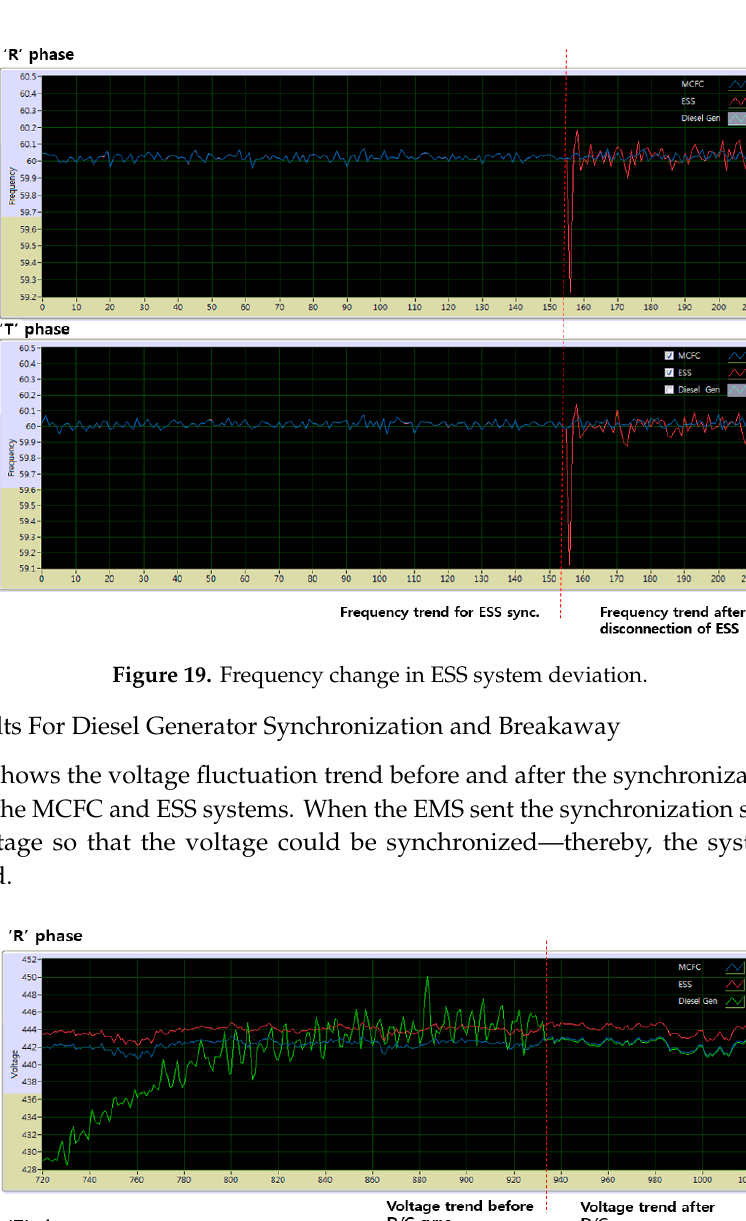
Figure 18. Voltage change when the ESS system was disconnected.